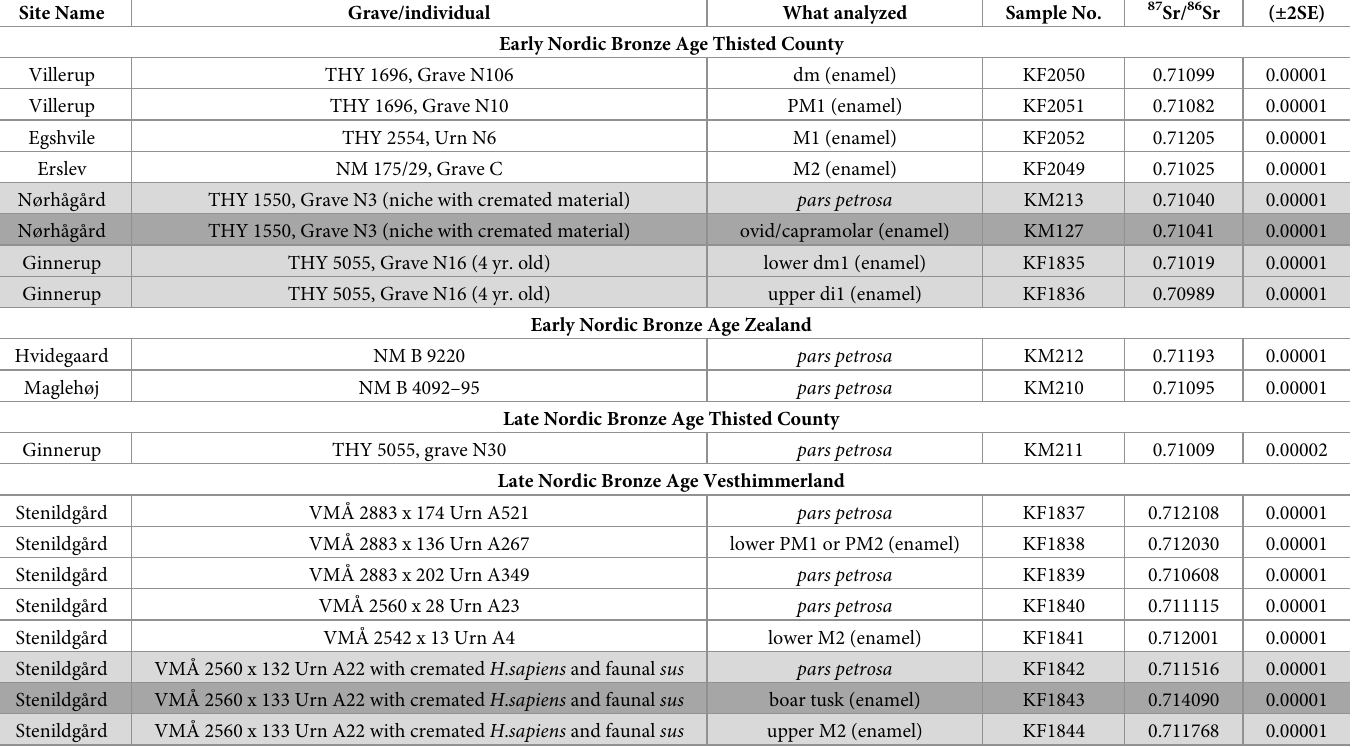
Table 6. Results of strontium isotope analyses of Early Nordic Bronze Age material from Thisted County and Zealand and Late Nordic Bronze Age material from Thisted County and